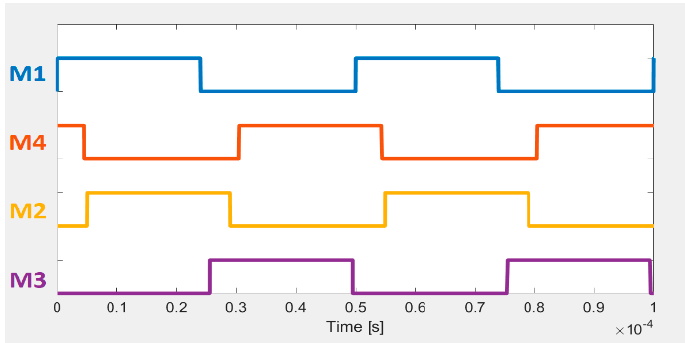
Figure 8. Transistors control signals (M1–M4) in the typical phase-shifted control method.